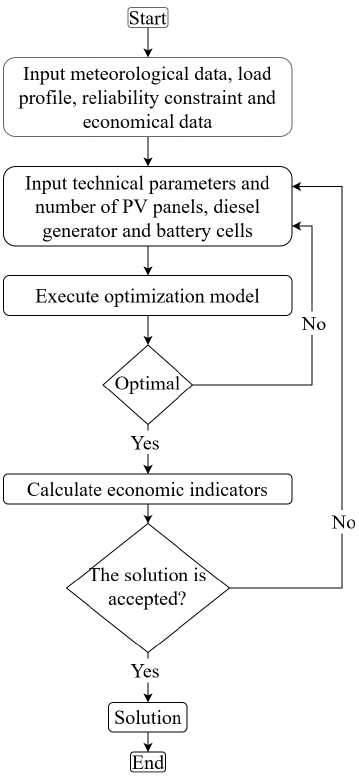
Figure 2. Schematic diagram of the proposed